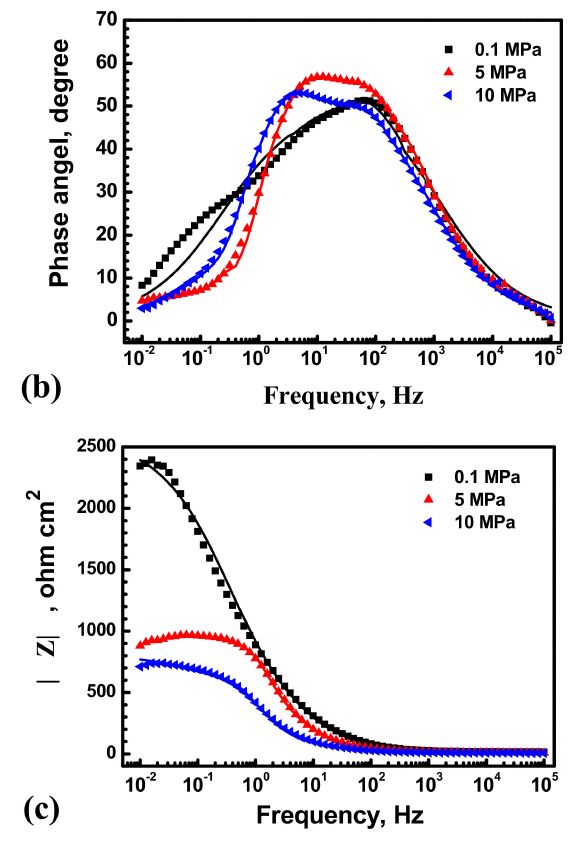
Figure 13. Impedance spectra of the X70 steel measured at the open circuit potential in 0.1 mol/L NaCl solution at 0.1 MPa, 5 MPa and 10 MPa. Solid lines represent fitted results. ( a ) Nyquist plot; ( b ) Bode-Phase angle plot; ( c ) Bode-impedance